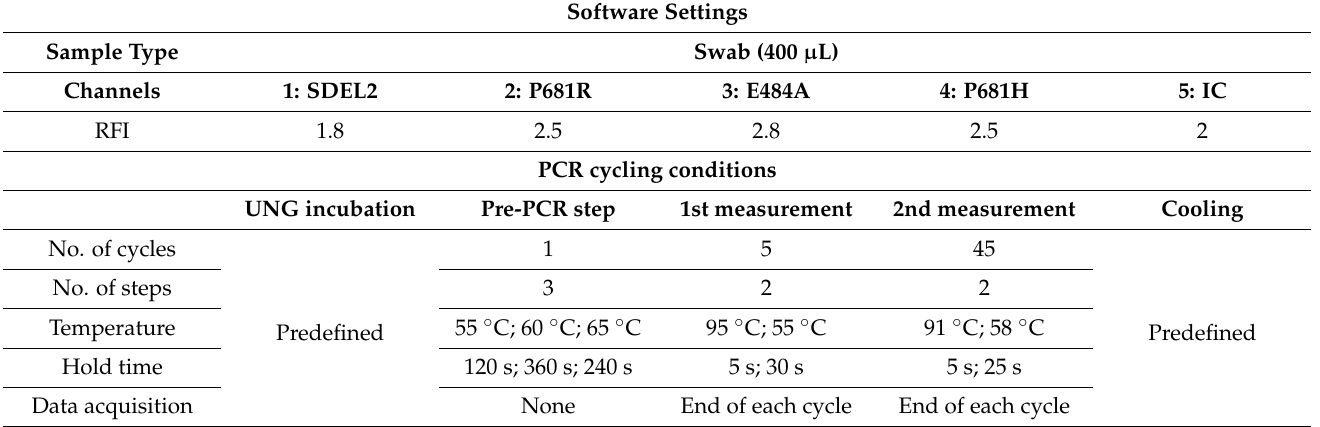
Table 2. Cobas omni Utility Channel run protocol for the SCOV2_OMIC_VOC-UCT. RFI (relative fluorescence increase) cut-offs are used to achieve specificity for a 100% sequence match for respective